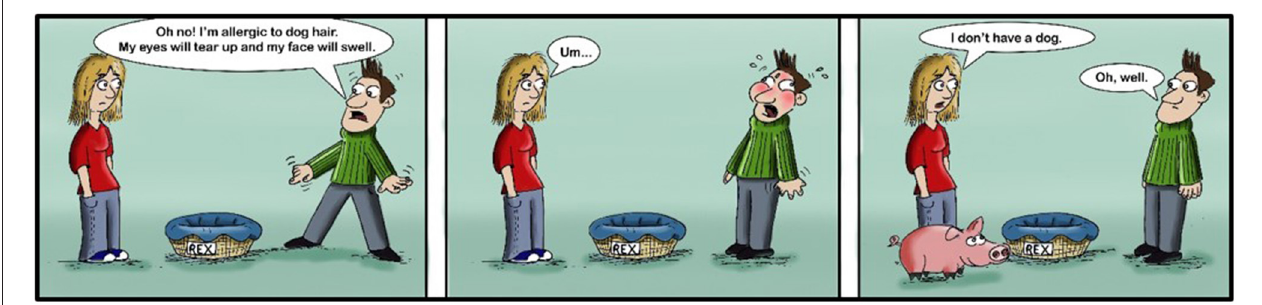
FIGURE 1 | Illustration of nocebo effects in everyday life. © Timm